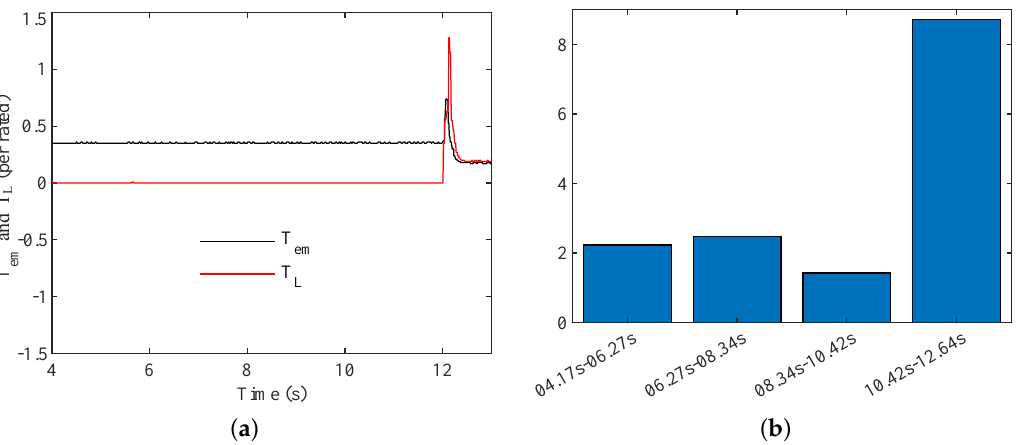
Figure 7. Pole-slipping detection using kurtosis: ( a ) the output of T em with respect to T L ; ( b ) kurtosis of T em (pole-slipping occurs at 12.1 s, and kurtosis is calculated individually with 200 samples of T em